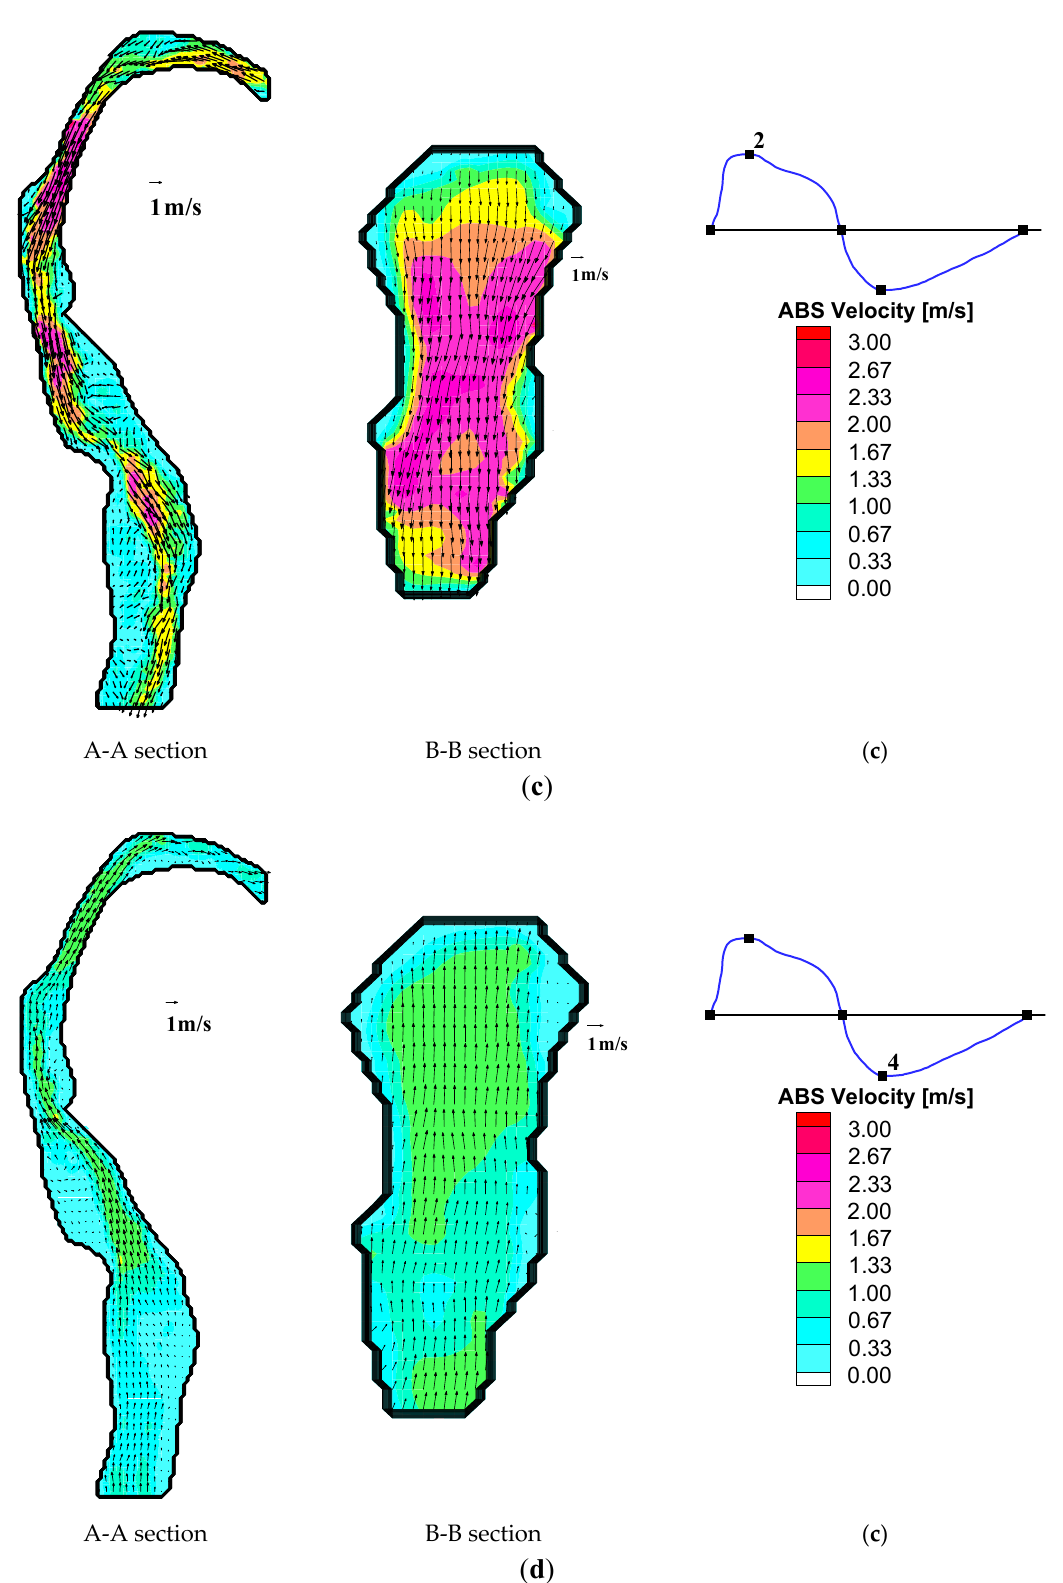
Figure 6. Measured results at four representative phases at A-A section and B-B section: ( a ) phase one: expiration-inspiration reversal transient; ( b ) phase three: inspiration-expiration reversal transient; ( c ) phase two: peak inspiration transient; ( d ) phase four: peak expiration transient.